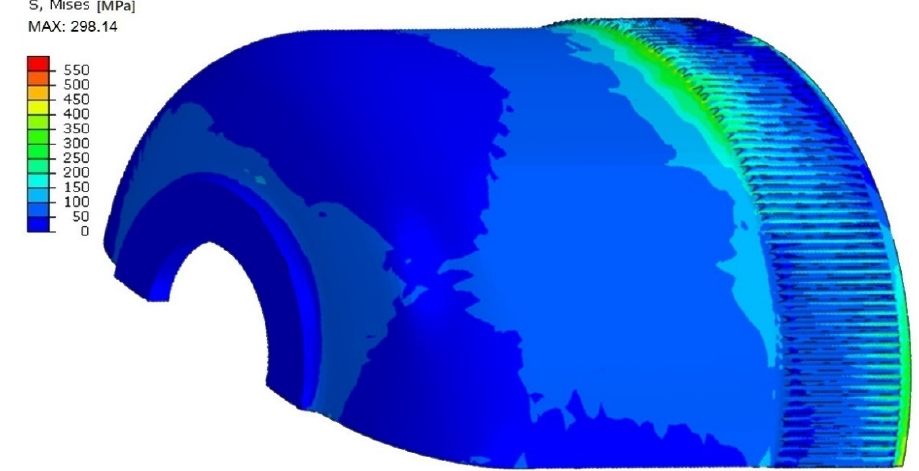
Figure 7. The distribution of the stresses in the flexspline model—variant III.